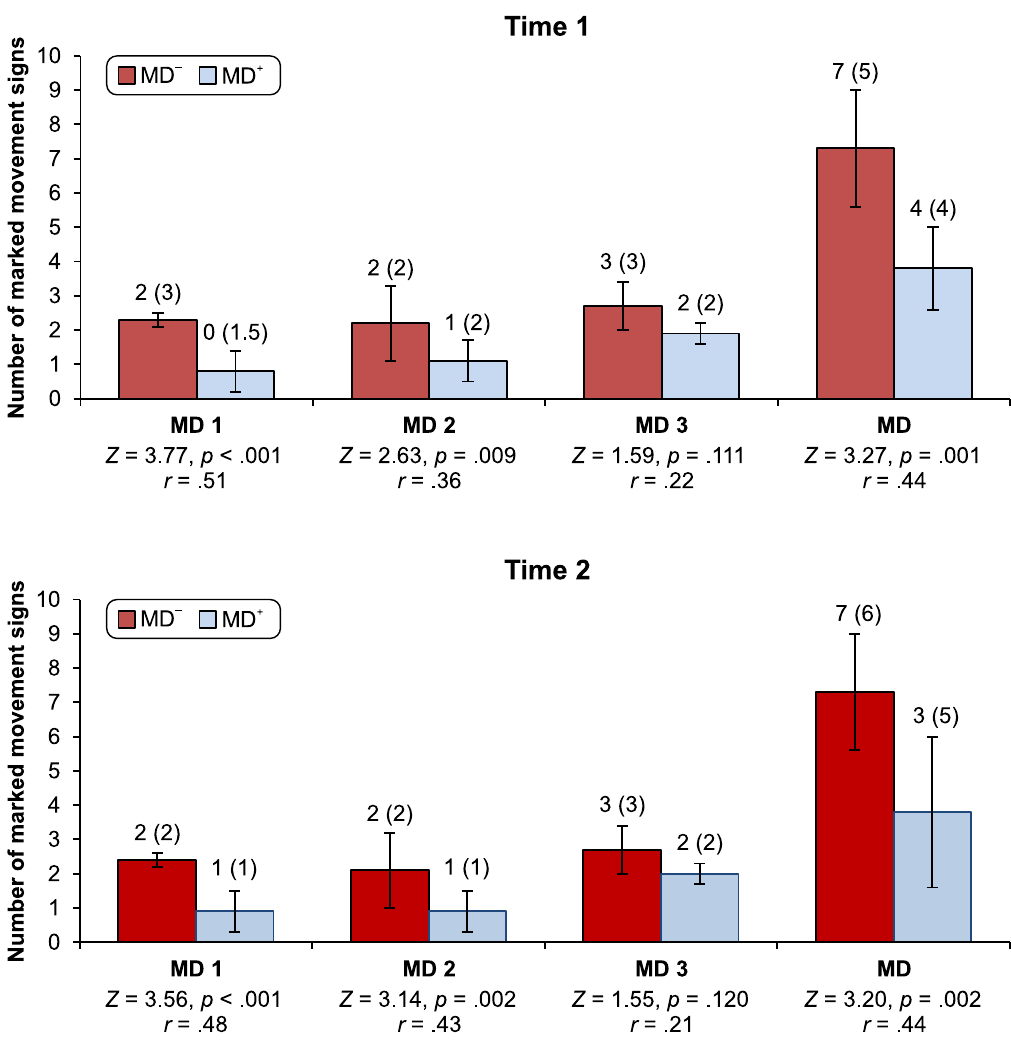
Figure 1. The number of movement signs marked by investigators in children with and without difficulties (MD – and MD + ) in manual dexterity, separately in Time 1 (observation) and Time 2 (re-observation). Values above the bars – median (IQR); MD 1, MD 2, MD 3 = the manual dexter- ity tasks; MD = sum of the MD tasks; Z = standardized value of U statistic; p = p -value (two-tailed, α = .05); r = effect